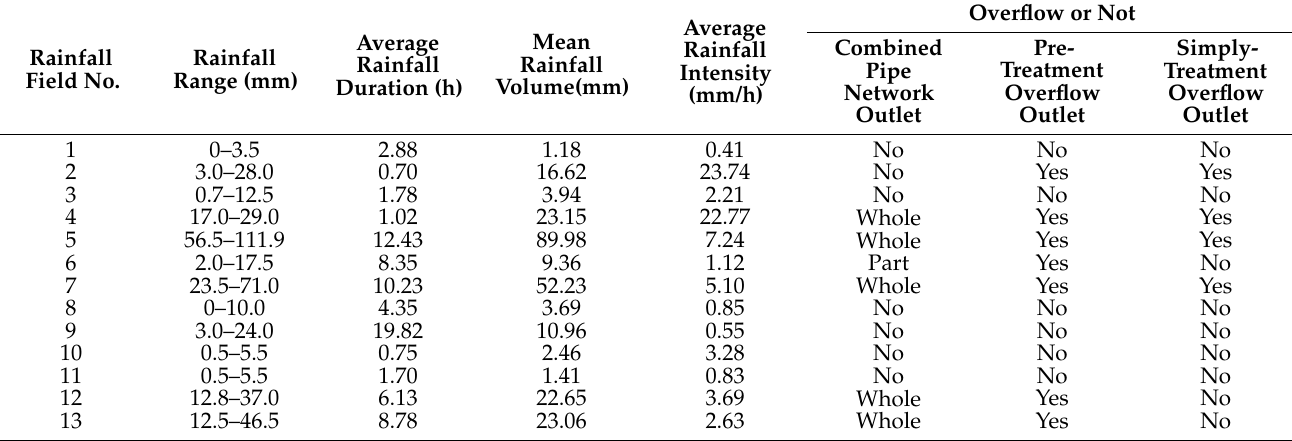
Table 3. Summary of rainfall characteristics and overflow